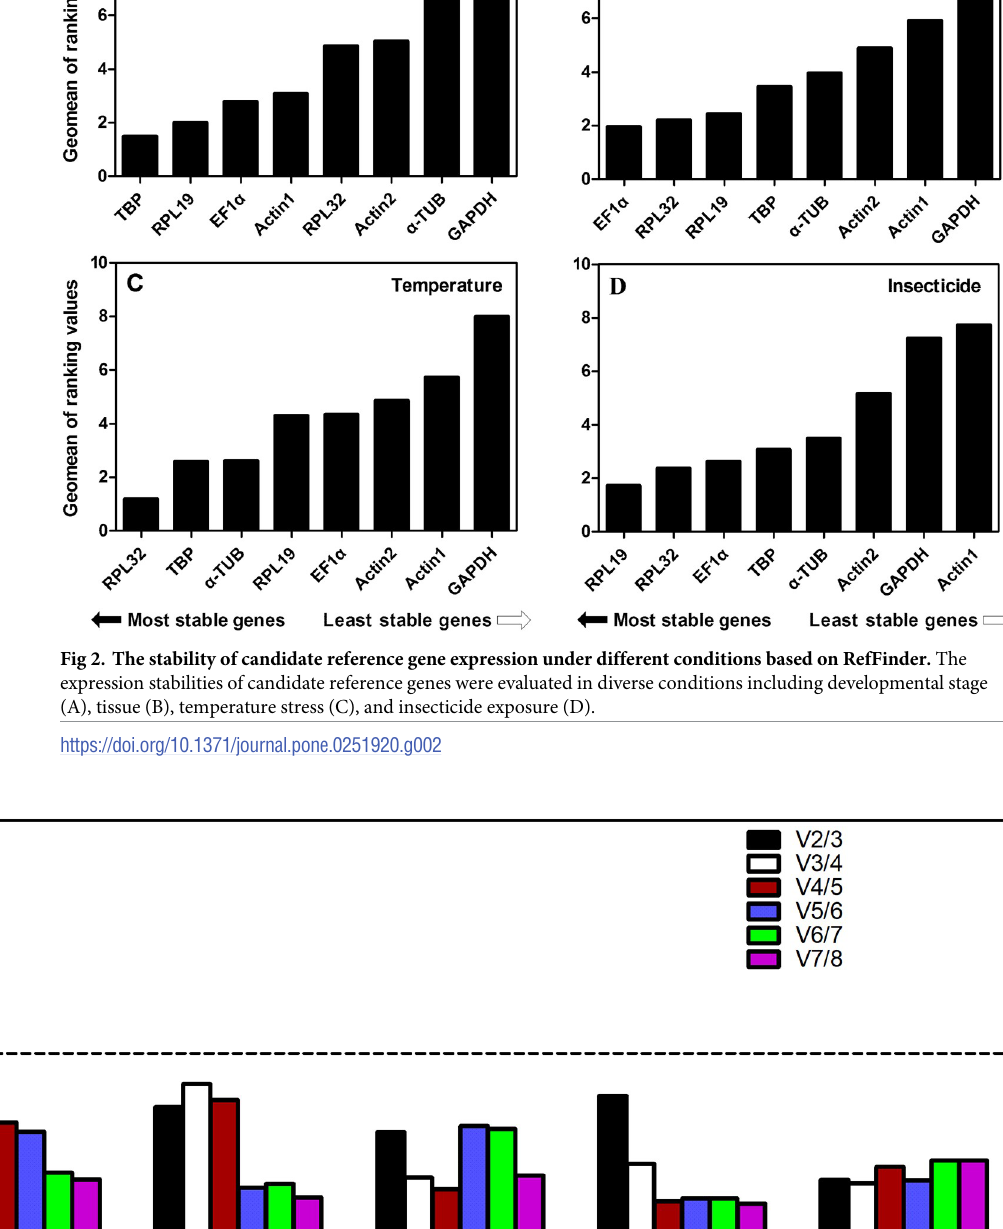
PLOS ONE | https://doi.org/10.1371/journal.pone.0251920 June 3,